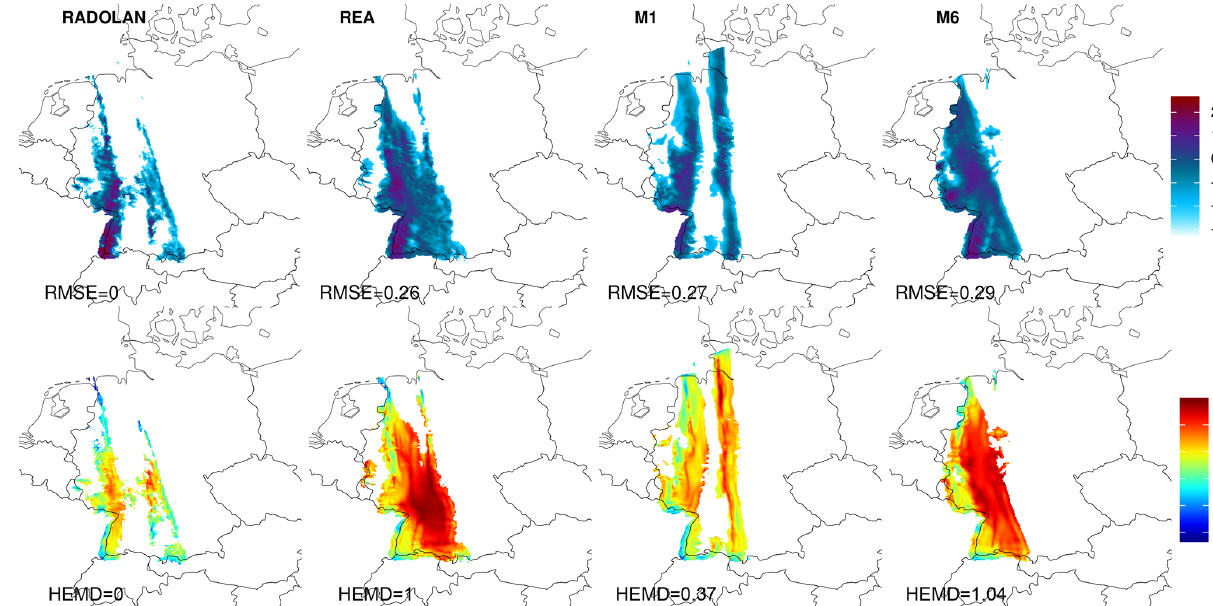
Figure 9. Logarithmic rain fields for 26 February 2011 at 19:00UTC (top row) and corresponding maps of central scales (bottom). From left to right: RADOLAN, REA and COSMO-DE-EPS ensemble members 1 and 6. All fields were cropped to the extent of the available RADOLAN